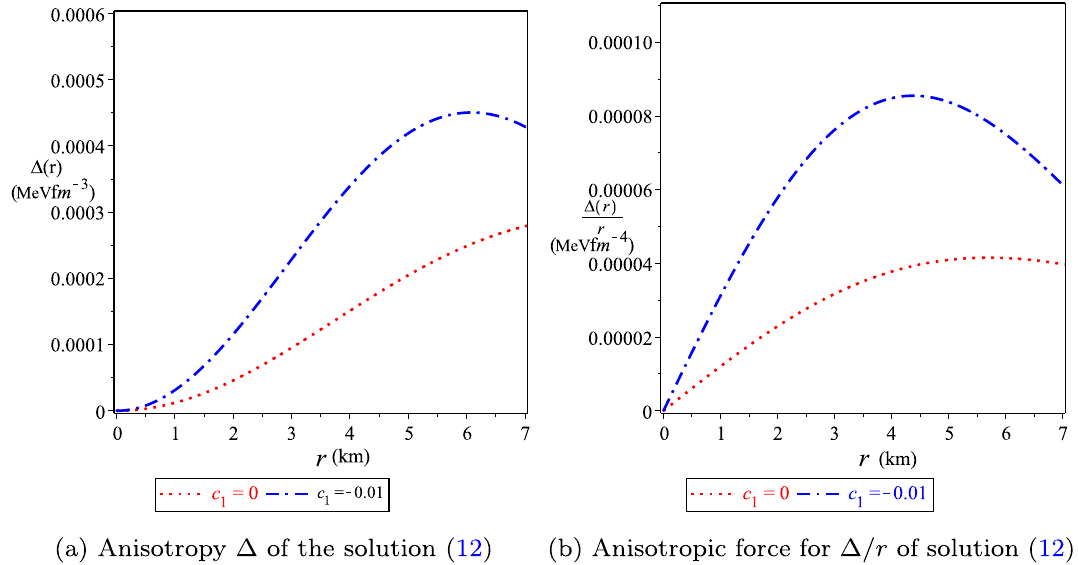
Fig. 4 Anisotropy (cid:15)( r ) and anisotropy force. Plot a shows that we have a repulsive force due to the positivity of the